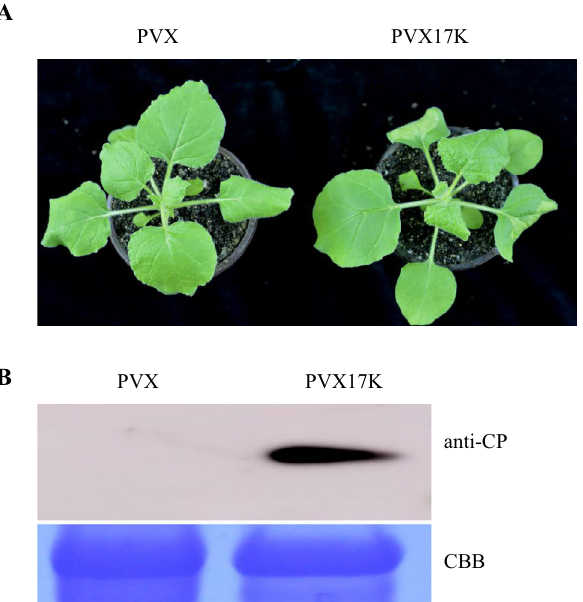
Figure 1. 17K promoted PVX infection in N. benthamiana . ( A ) Disease symptoms exhibited in N. benthamiana leaves inoculated with PVX or PVX17K. ( B ) PVX accumulation in the PVX- or PVX17K-inoculated N. benthamiana leaves were detected by conducting Western blotting analysis with anti-CP antibodies. Coomassie Brilliant Blue (CBB) staining of the large subunit of RuBisCo served as loading